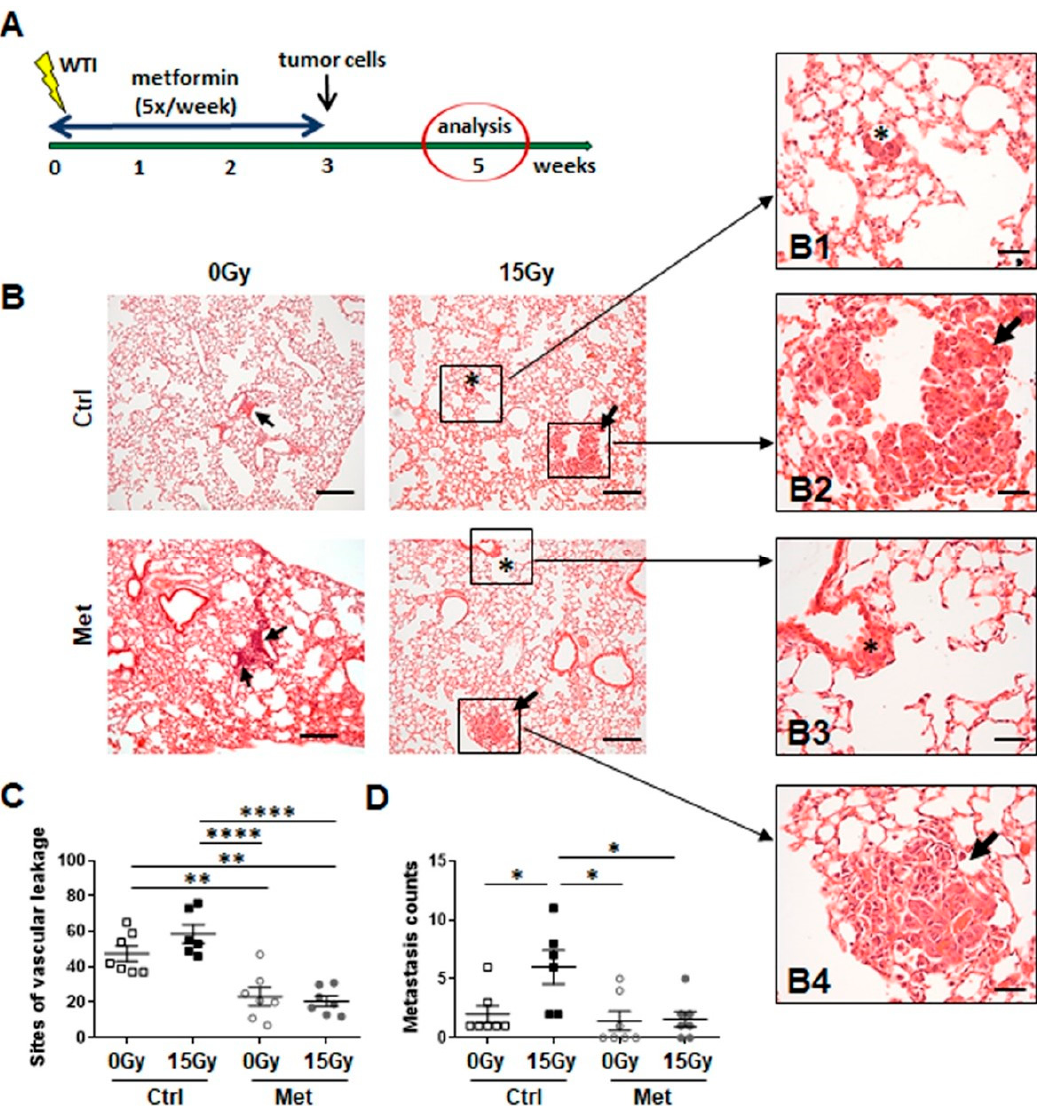
Figure 3. Metformin treatment limits metastasis formation in previously irradiated lung tissue. ( A ) C57BL/6 mice were left untreated (Ctrl), received metformin (Met) treatment, 15Gy WTI or received WTI in combination with metformin (Met) treatment for first three weeks post WTI. ( B ) Seeding of circulating tumor cells into the lungs was initiated 21 days after irradiation. Therefore, 0.5 × 10(6) metastatic tumor cells were intravenously transplanted via the tail vein of C57BL/6 mice. Fourteen days after tumor cell injection animals were sacrificed, lungs were isolated and subjected for lung histopathology using hematoxylin and eosin staining. Areas of extravasated tumor cells were emphasized by asterisks (B1, B3). Arrows point towards formed metastases (B1, B4). Scale bar: 200 µ m; magnifications: 40 µ m. ( C ) Sites of vascular leakage (designated as sites of tumor cell extravasation/micrometastasis) and ( D ) subsequently formed macrometastasis were quantified in whole lung sections (0Gy Ctrl, 0Gy Met, 15Gy Met: n = 7 per group; 15Gy ctrl: n = 6). Data are shown as individual biological replicates with mean values ± SEM. p -values indicate: * p ≤ 0.05, ** p ≤ 0.01, **** p ≤ 0.0001 by one-way ANOVA with post hoc Tukey’s multiple comparison test.